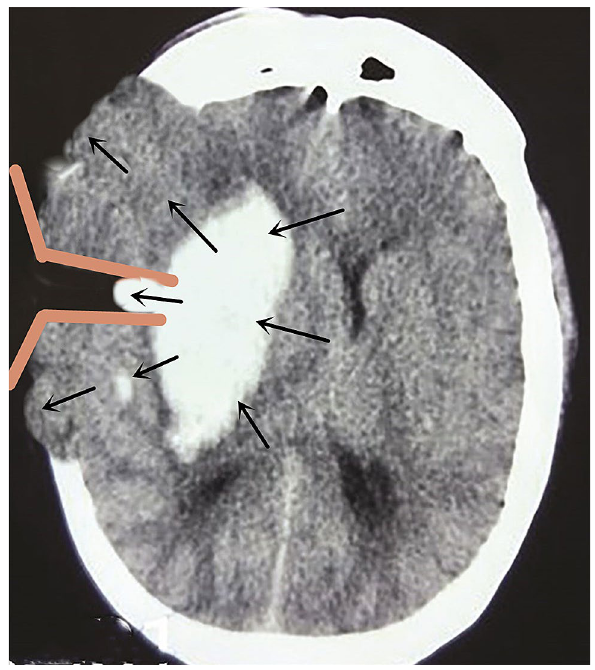
Figure 5. In the craniotomy group, after removing the flap and opening the dura, because of the pressure difference of “distant brain-hematoma-brain tissue around bone window”, some brain tissue bulged out from bone window under the influence of brain tissue pressure and hematoma pressure, significantly decreasing the brain tissue pressure. Thus, in the process of hematoma removal, the pressure difference of "brain-hematoma " hardly forms. The hematoma does not retract and is not easy to remove. The only way for removal is the use of a brain spatula to pull brain tissue and reveal hematoma for clearance, which is also challenging because excessive pulling can easily damage brain